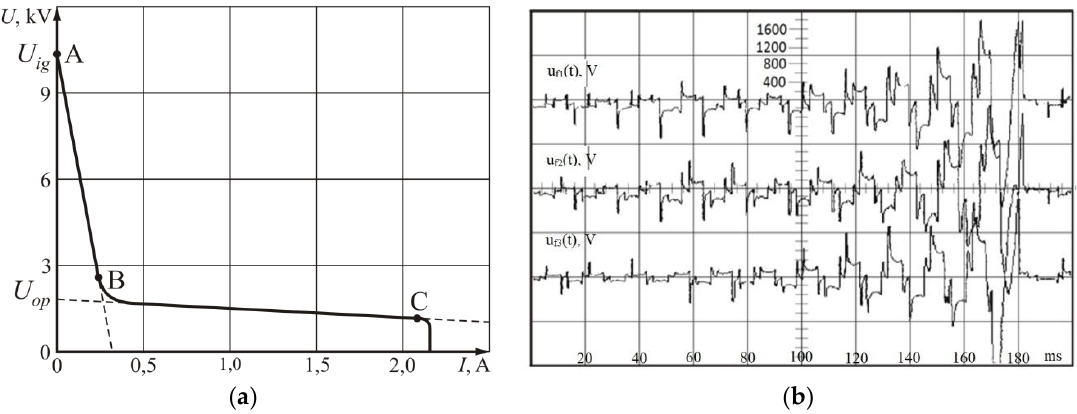
Figure 2. (a) Characteristics of the IPSS (A-B ignition voltage characteristic, B-C operating voltage characteristic); ( b ) phase voltages u f1 (t), u f2 (t) and u f3 (t) on the 3-electrode GAD reactor during the discharge in air at flow rate of 10 lit/min, supply voltage frequency f = 50Hz.